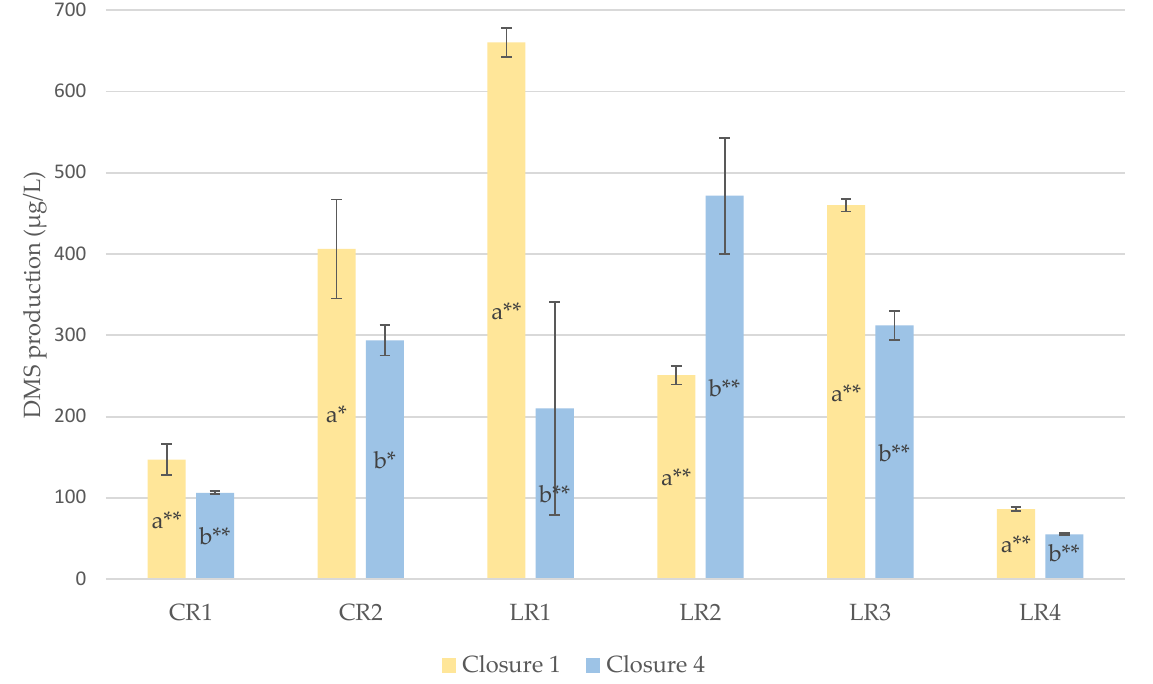
Figure 2. DMS formation after three months of accelerated bottle ageing depending on closure 1 (OTR = 0.19 mg O 2 /year) and closure 4 (OTR = 1.79 mg O 2 /year) for each wine sample (a and b: a different letter means there is a significant difference between the two groups; **: significant difference at 5%; *: significant difference at 10%).